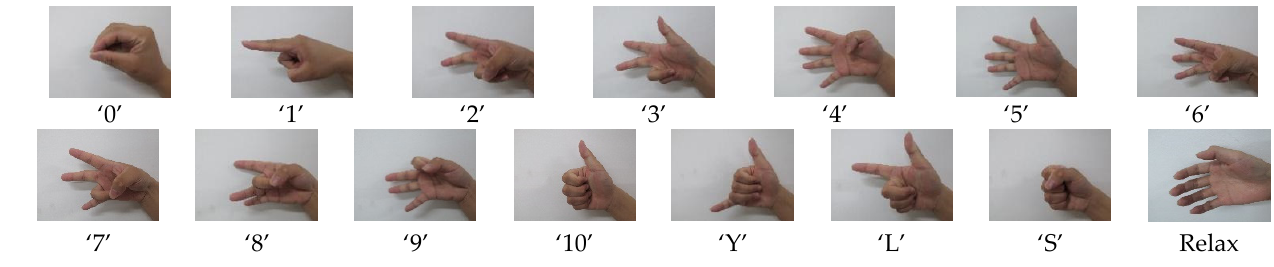
Figure 4. The hand gestures for data capturing.